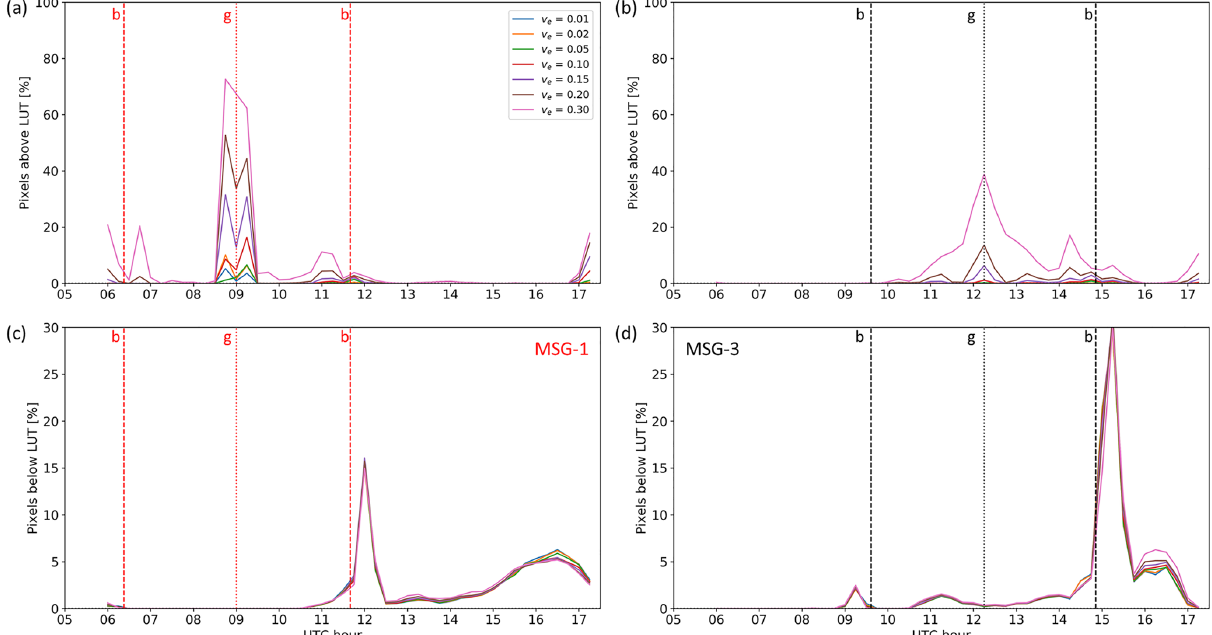
Figure 9. Fraction of flagged pixels (in %) with pairs of reflectances lying above (a, b) or below (c, d) the retrieval LUT, shown separately for MSG-1 (a, c) and MSG-3 (b, d) on 7 March 2017 over the southeastern Atlantic. The results are shown for seven LUTs, corresponding to the seven values of ν e shown in (a) . The vertical lines represent cloud glory (dotted, denoted with “g”) and cloud bow (dashed, denoted with “b”) geometries for MSG-1 (red) and MSG-3